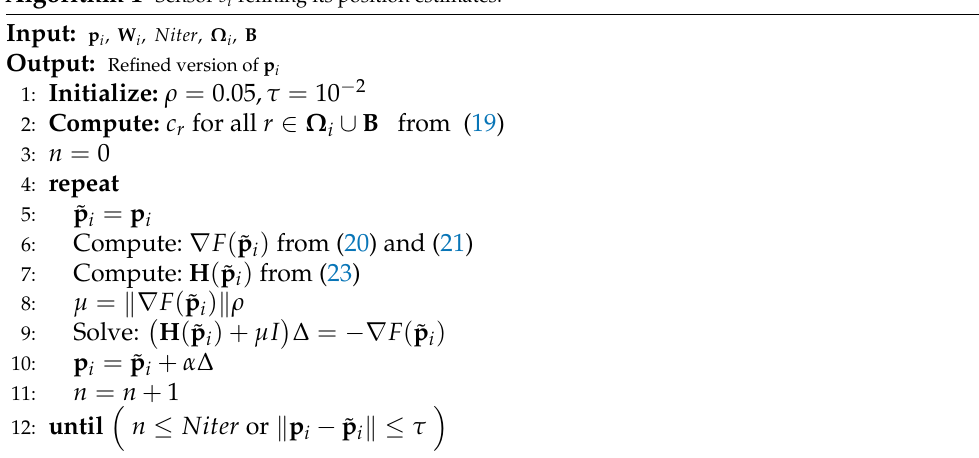
Algorithm 1 Sensor s i refining its position